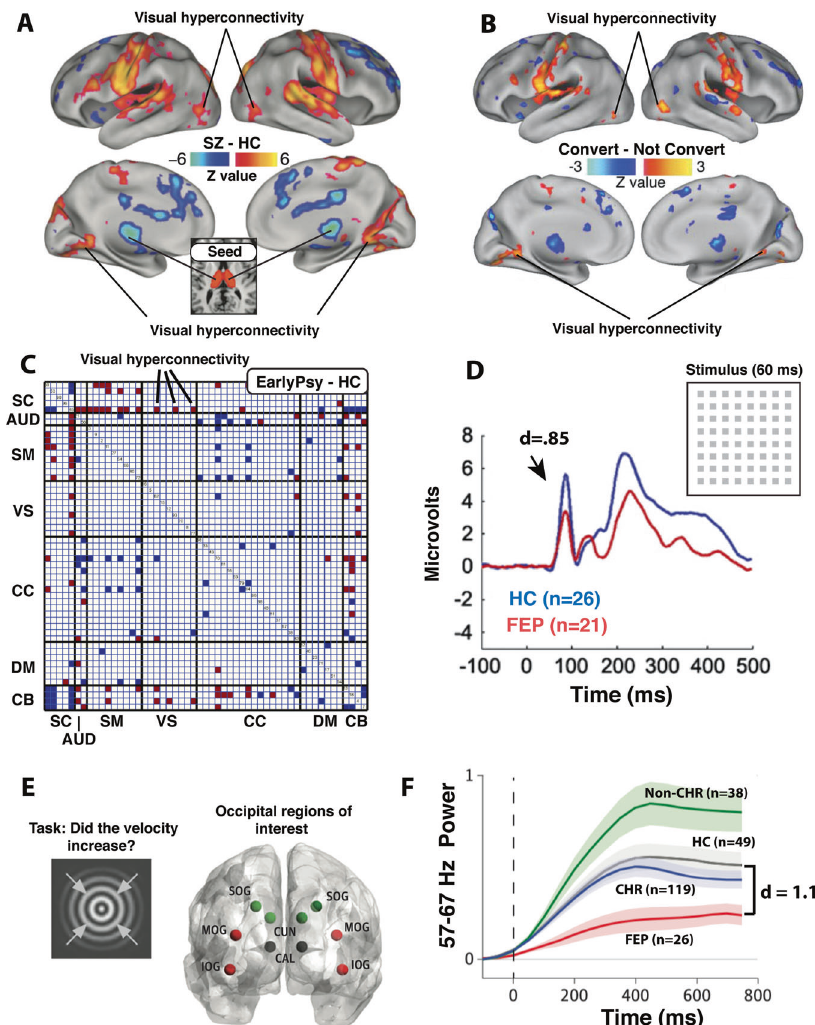
Fig. 2 Visually oriented brain-based markers of early psychosis. A Visual thalamo-cortical hyperconnectivity occurs in schizophrenia patients relative to HCs (Figure panel shows the thalamic seed; adapted with permission from [58]). B Similar hyperconnectivity patterns have been observed in CHR patients who convert versus those who do not convert to a psychotic disorder (Adapated with permission from [61]). C Different investigators have found comparable patterns (after FDR correction) in early-stage non-affective psychosis patients relative to HCs, with one-third of the visual nodes being hyperconnected to the thalamic node (Adapted with permission from [60]). D Brie fl y fl ashed checkered images have elicited a muted P1 amplitude in FEPs relative to HCs (Adapted with permission from [65]). E , F During a change-in- motion detection task, gamma band activity within ten occipital regions was smallest in FEP subjects, intermediate in CHR patients, and greatest in psychiatric patients not meeting CHR criteria (non-CHR) (Adapted with permission from